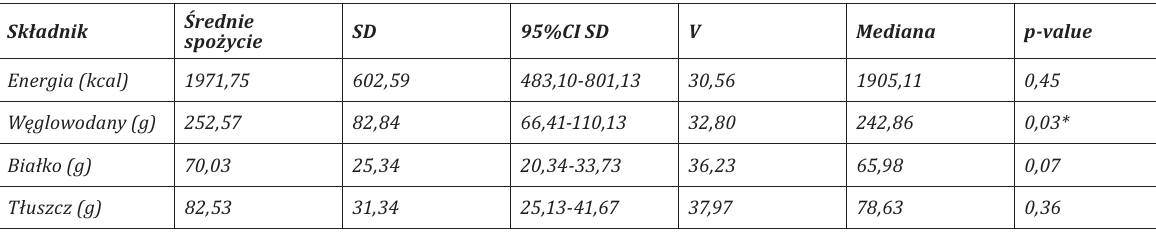
Tabela 2. Wartość energetyczna i zawartość makroskładników w dietach badanych